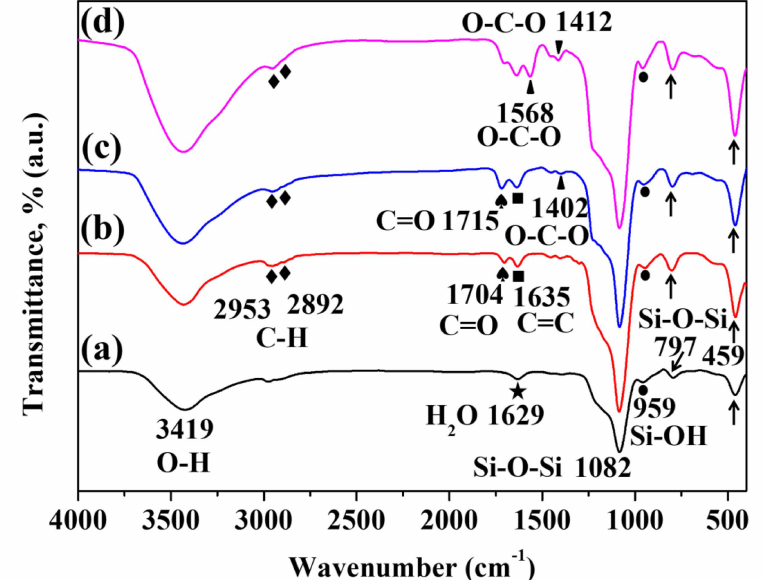
Figure 7. FT-IR spectra of ( a ) MCM-41, ( b ) MCM-41-TMSPM, ( c ) MCM-41-PAA, and ( d ) Ca@MCM- 41-PAA_5-FU. ( (cid:7) C-H, ♠ C=O, (cid:4) C=C, (cid:78) O-C-O, (cid:70) H 2 O, • Si-OH, →